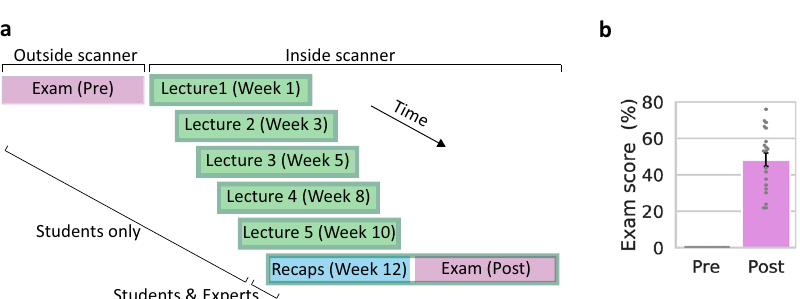
Fig. 1 Study design and exam scores. a Study design. Students enrolled in an introduction to computer science course underwent six fMRI scans throughout the course. During the fi rst fi ve scans, students were shown course lecture videos. On the fi nal scan (bottom), students were shown lecture recaps and given a fi nal exam. Experts underwent the fi nal scan only. See Table 1 for stimuli and task details. b Exam scores. Pretest (left) was performed prior to scanning, posttest (right) was performed during scan 6. Individual students ( n = 20) are shown in gray. Error bar, ±1 s.e.m. Table 1 Stimuli and